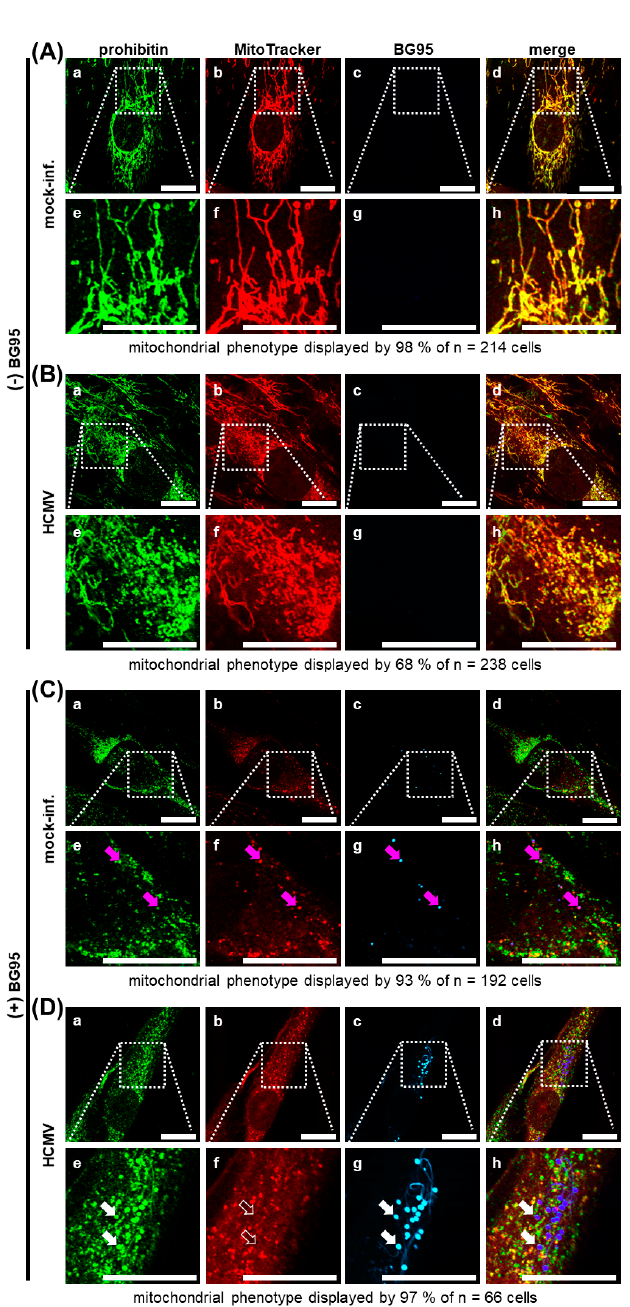
Figure 5. Autofluorescent BG95 accumulates in characteristic intramitochondrial bodies converting mitochondria to an inactive state. ( A ) Mitochondria of untreated, mock-infected cells consistently display a filamentous structure as visualized by overlapping prohibitin and MitoTracker signals (compare also Figure 3). ( B ) HCMV infection induces dispersed mitochondria as visualized by overlapping prohibitin and MitoTracker signals (see drug autofluorescence-negative images c and g as a control). ( C ) Treatment with 10 µ M BG95 causes a punctate mitochondrial phenotype and drug autofluorescence. Magenta arrows indicate strong BG95 autofluorescence with the corresponding positions in other channels. Note some loss of overlap between prohibitin and MitoTracker signals. ( D ) Combined, BG95 treatment and HCMV infection led to strongly autofluorescent BG95 bodies colocalized with prohibitin, but not with the MitoTracker signal. White arrows indicate exemplary BG95 bodies, which display a lack of MitoTracker signal at these specific sites (unfilled arrows). White dotted frames indicate the area enlarged in the respective inset, connected by dotted lines. Scale bars represent 20 µ